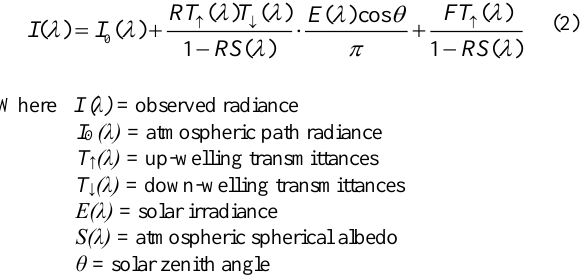
Figure 1. Example of TanSat-ACGS L1b radiance (a) and